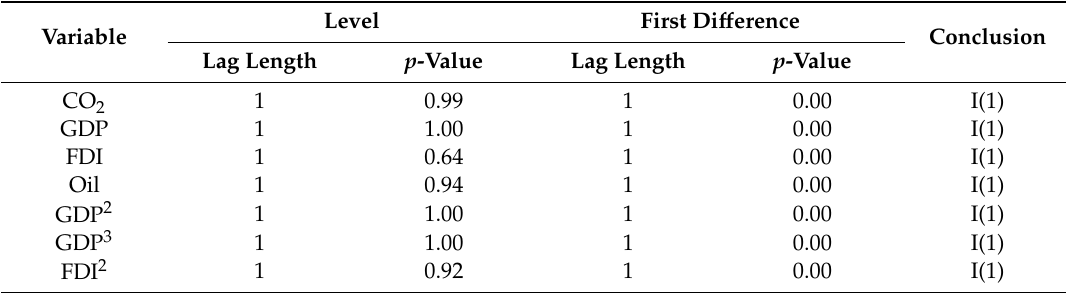
Table 4. Root test